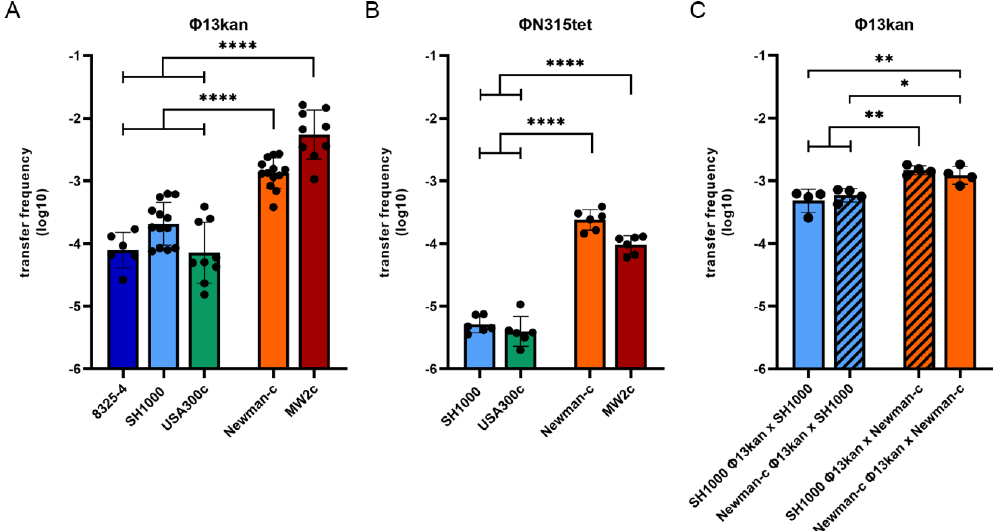
Figure 1. Phage transfer frequency of Ф 13kan ( A , C ) or Ф N315tet ( B ) is strain-dependent. Lysogens were mixed with isogenic, phage-cured, streptomycin-resistant recipients 8325-4 (dark blue), SH1000 (light blue), USA300c (green), Newman-c (orange), or MW2c (dark red) at a 1:1 ratio (4 h co-culture in tryptic soy broth) ( A , B ) or with non-isogenic recipients ( C ). Phage transfer frequency was determined by calculating the ratio of CFU of double-resistant colonies (kanamycin/streptomycin for Ф 13kan or tetracycline/streptomycin for Ф N315tet, respectively) divided by CFU on streptomycin (representing recipient). Values are independent biological replicates referring to mean ± SD. Statistical analysis was performed on log-transformed data using one-way ANOVA. * p ≤ 0.05, ** p ≤ 0.01, **** p ≤ 0.0001.